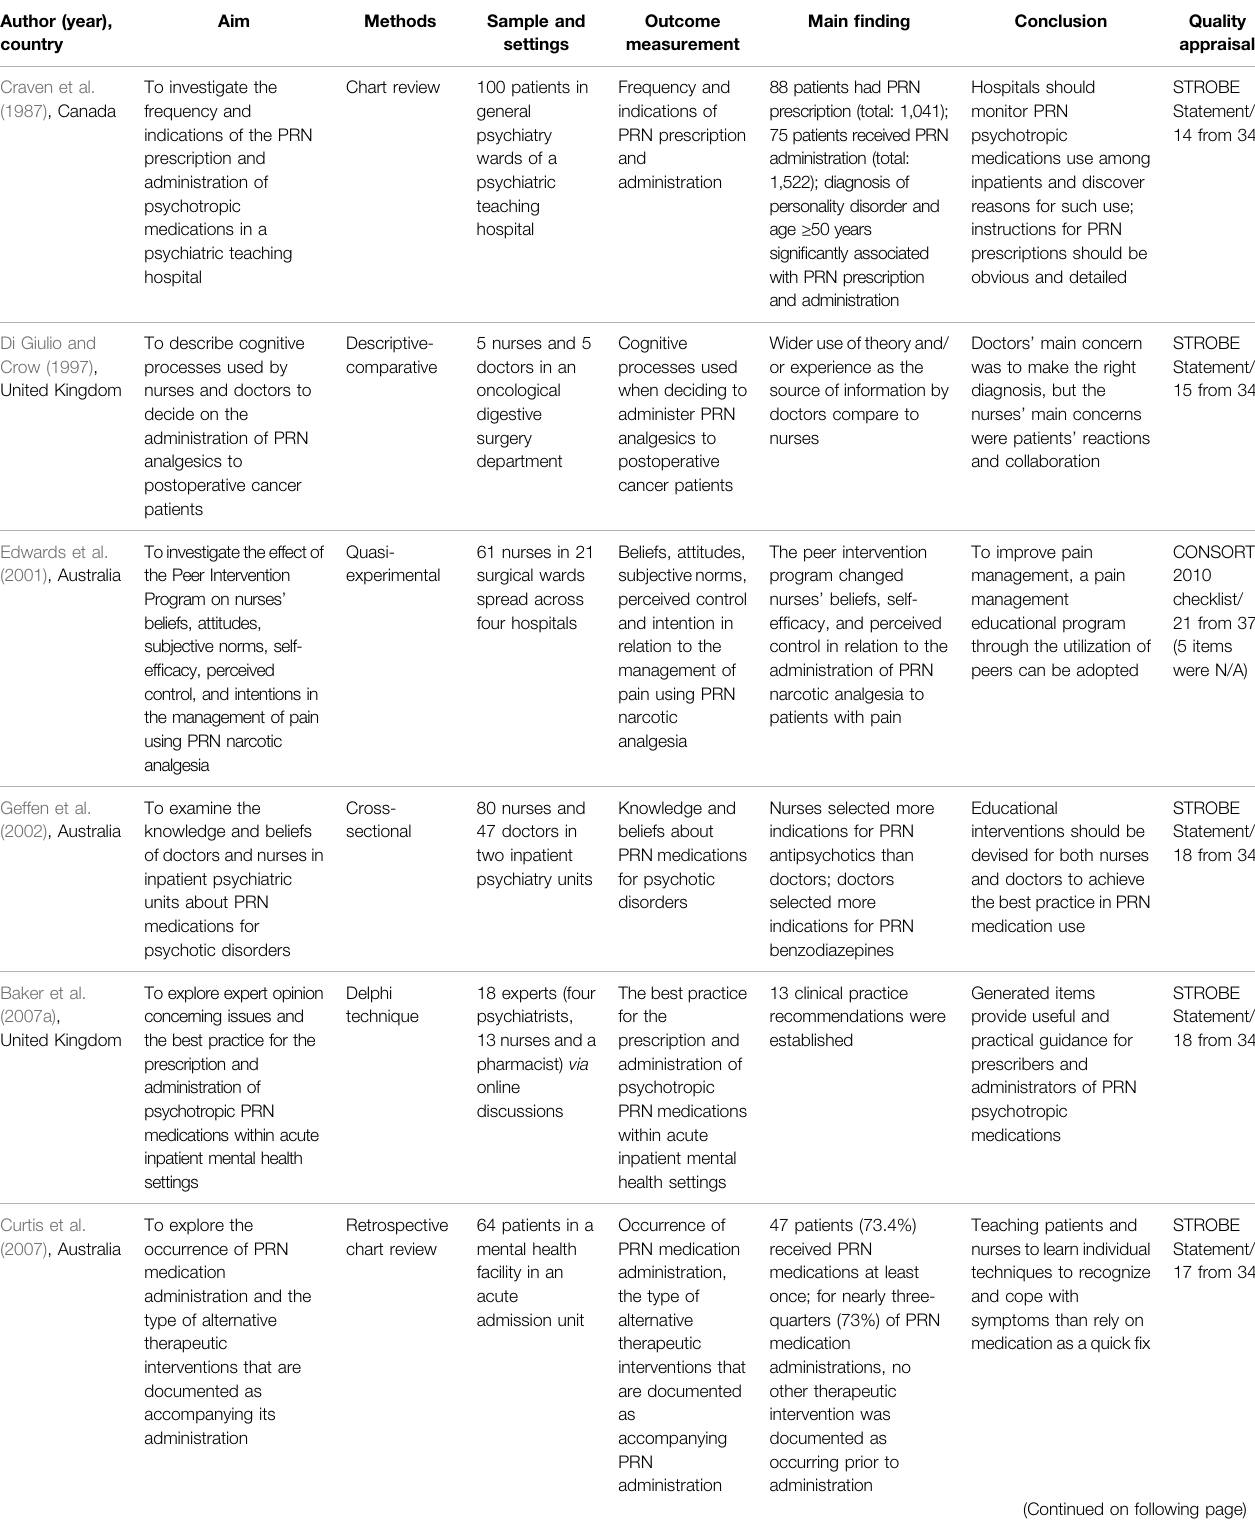
TABLE 2 | General characteristics of the included studies to our data analysis and knowledge